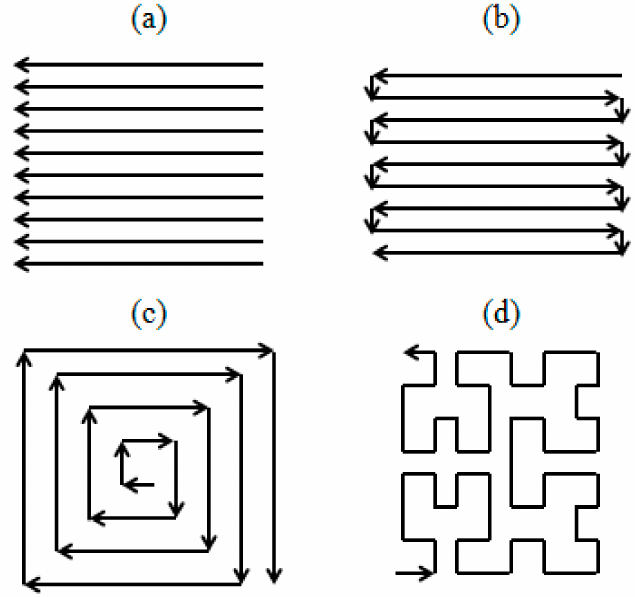
Figure 12. Different deposition patterns: ( a ) raster, ( b ) bi-directional, ( c ) offset-out, and ( d ) fractal.